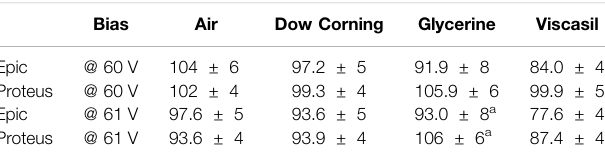
a Measurement at a bias voltage of 60.8 V, since 61 V showed a excessive noise in this con fi guration.